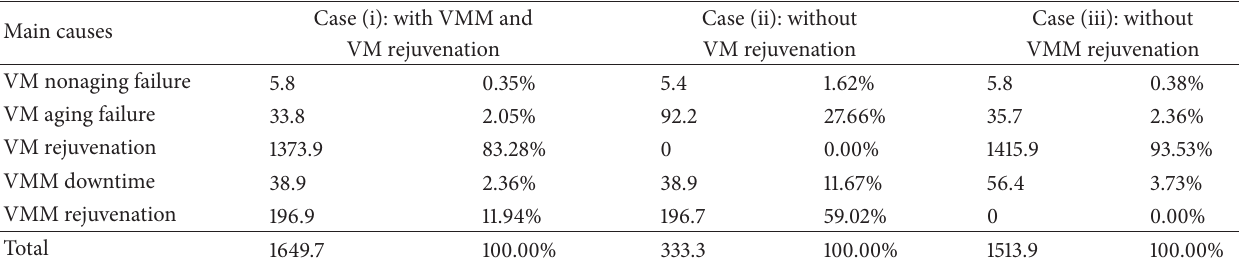
Table 7: Expected number of transaction loss per year of VMs